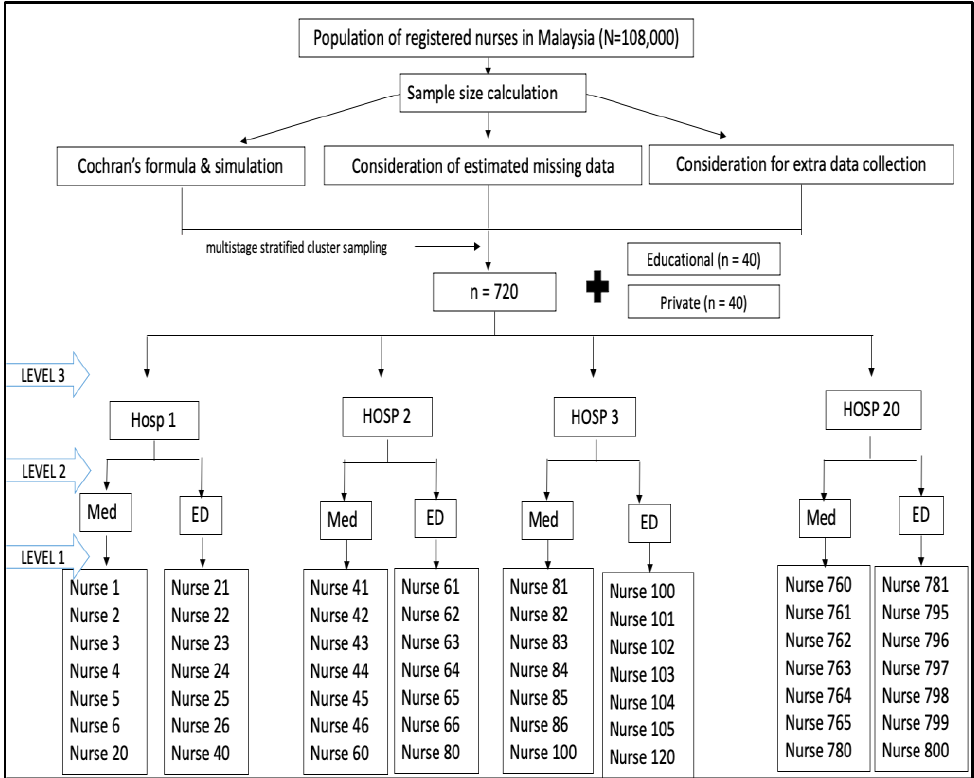
Figure 2. Subject recruitment.